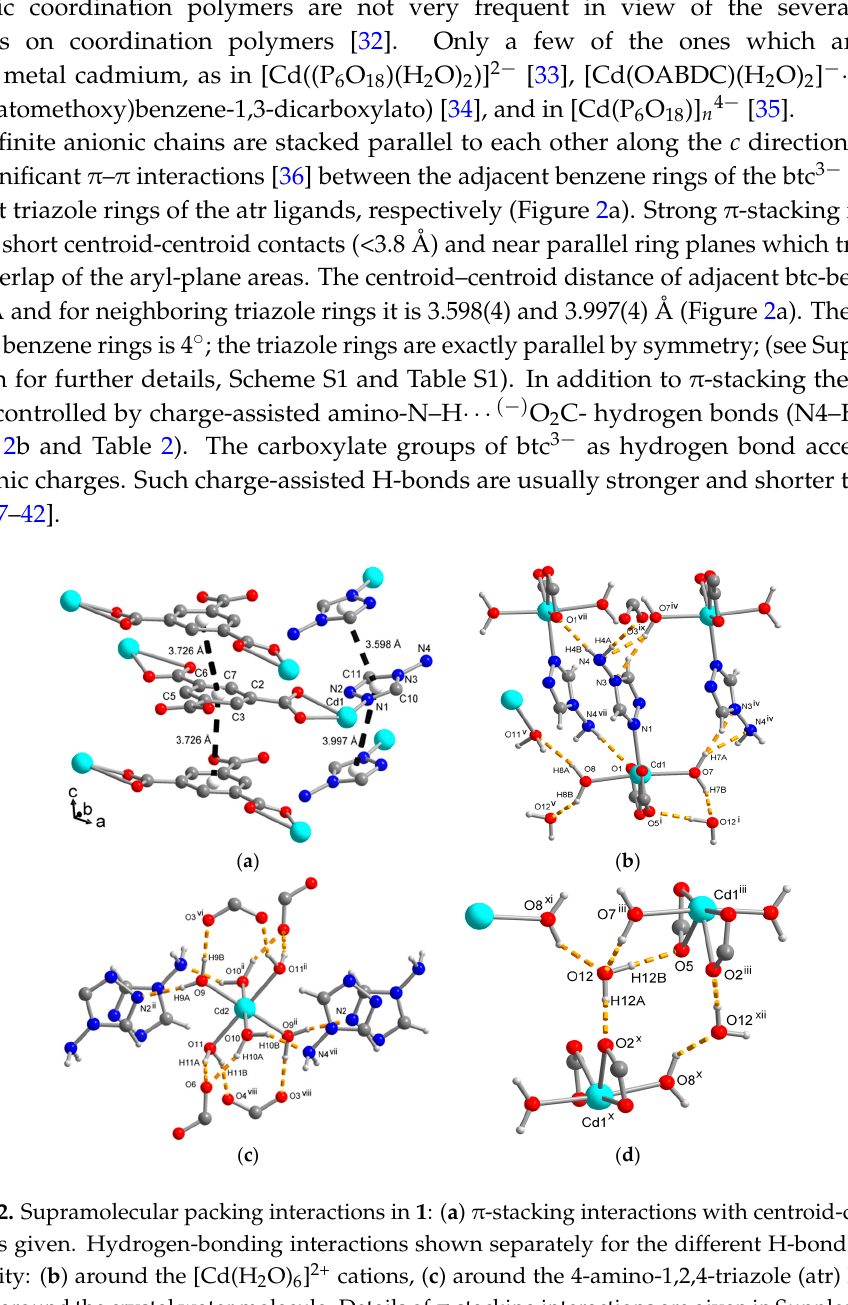
Table 2. Details of the hydrogen bonding interactions in 1 a .